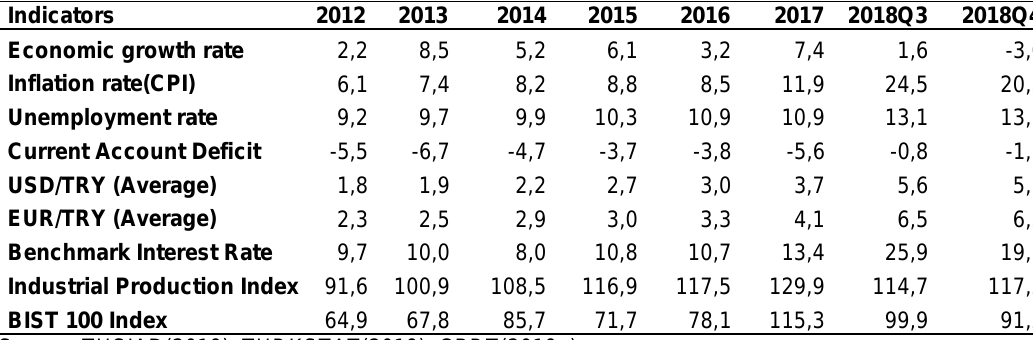
Table 1. Macro-financial Indicators: 2012-2018.